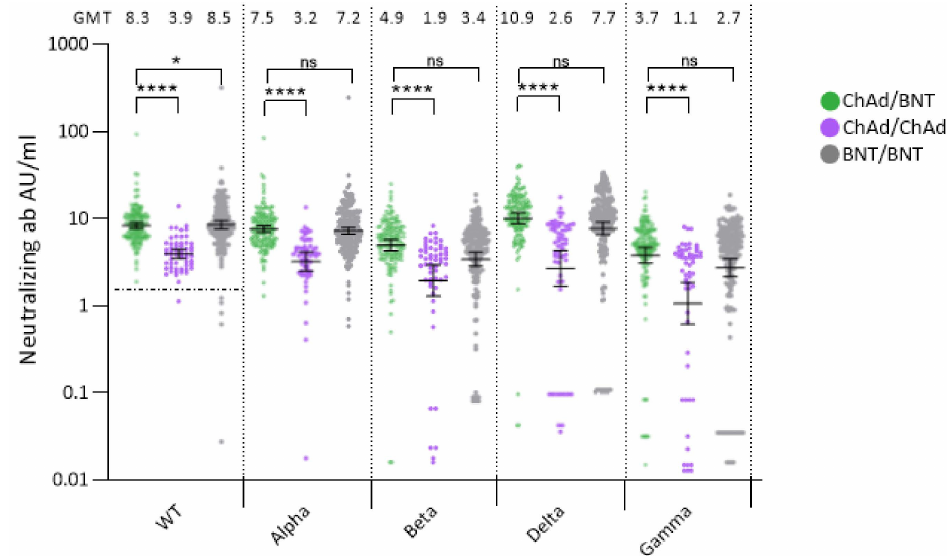
Figure 2. Surrogate virus neutralization GMT 3 months post heterologous ChAd/BNT ( n = 149, median time to sampling 90 days (range 82–105)) and homologous ChAd/ChAd ( n = 56, median time to sampling 98 days (range 77–105)) primary vaccination in SARS-CoV-2 naïve participants. Samples 3 months post homologous BNT/BNT ( n = 210, median time to sampling 87 days (range 75–104)) are presented for reference. Dotted line (wt) represents cut-off value set by the manufacturer. * p = 0.0252, **** p < 0.001, ns; not significant. Ab; antibodies, WT; wild type, AU; Arbitrary Units, ChAd; ChAdOx1 nCoV-19 vaccine, BNT; BNT162b2 mRNA